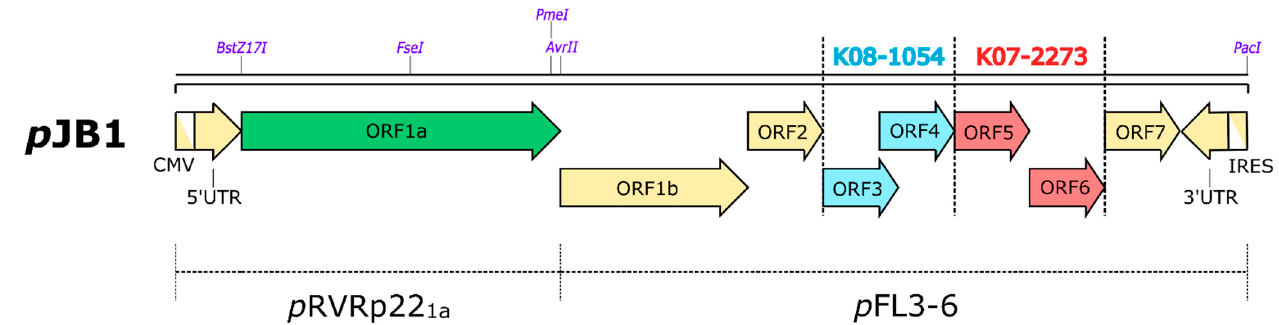
Figure 1. Graphical representation of the genomic construct for chimeric infectious clone p JB1 ( p RVRp22–1aK3–6). The restriction sites used for cloning are listed above the construct. CMV: human cytomegalovirus; IRES: internal ribosomal entry site; BstZ17I , FseI , AvrII , PmeI , PacI : restriction sites.